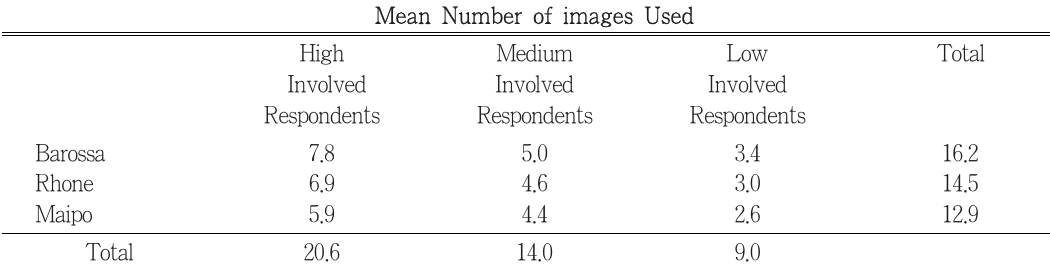
<Table 3> Mean Number of Sensory images used by Wine